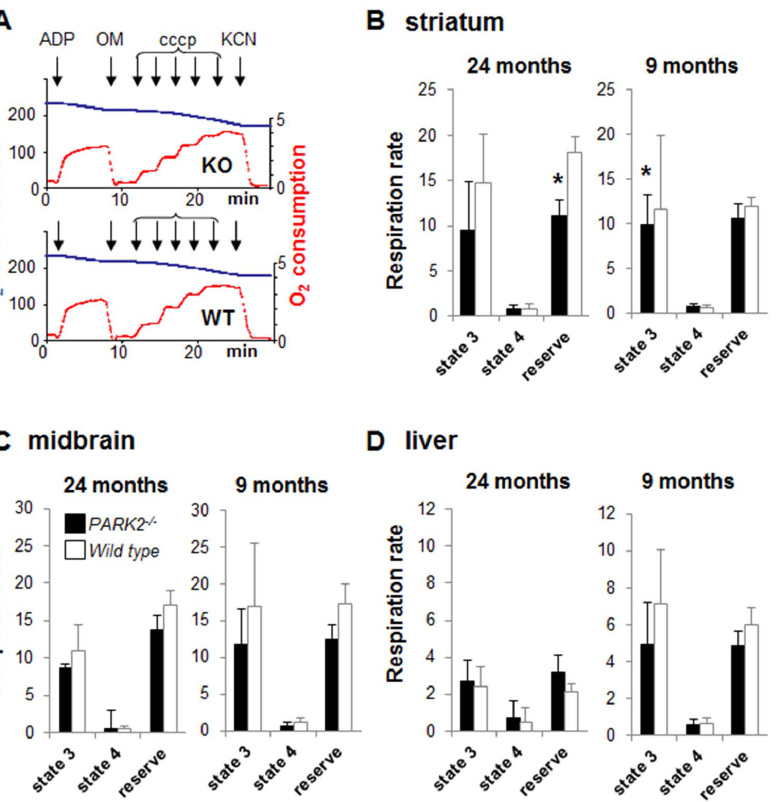
Figure 2. High resolution respirometry reveals a respiration defect in PARK2 2 / 2 mice. ( A ) Representative experiment with striatal post- nuclear supernatant. Blue curve=oxygen concentration (O 2 ) expressed as nmol/mL; red curve=rate of oxygen consumption expressed as nmoles O 2 /mL and min; successive additions: ADP=1 mM ADP in the medium with 10 mM glutamate + 5 mM malate; OM=1 m g/mL oligomycin, cccp=successive additions of 1.25 m M (up to the maximal respiration rate independent from ATP synthase capacity); KCN=1 mM KCN (non- respiratory oxygen consumption); ( B, C, D ) Bars showing state 3 respiration, state 4 respiration and respiratory reserve on complex I substrates (glutamate + malate) in post-nuclear supernatants from (B) striatum, (C) midbrain and (D) liver of 24- and 9-month-old PARK2 2 / 2 (black bars) and wild type mice (white bars); all data are expressed as nmoles O 2 /mL and mg proteins and shown as means 6 SD; two animals, one per genotype, were analyzed the same day; the data were obtained from 6 to 8 individual animals of each genotype. * p , 0.05 using Mann and Whitney test. In liver, state 3 respiration rate and respiratory reserve significantly decreased with age in both wild type mice (p=0.011 and , 0.001 when comparing state 3 respiration and respiratory reserve respectively between 9 and 24 months of age using Mann and Whitney test) and in PARK2 2 / 2 mice (p=0.019 and , 0.001 when comparing state 3 respiration and respiratory reserve respectively between 9 and 24 months of age using Mann and Whitney test).